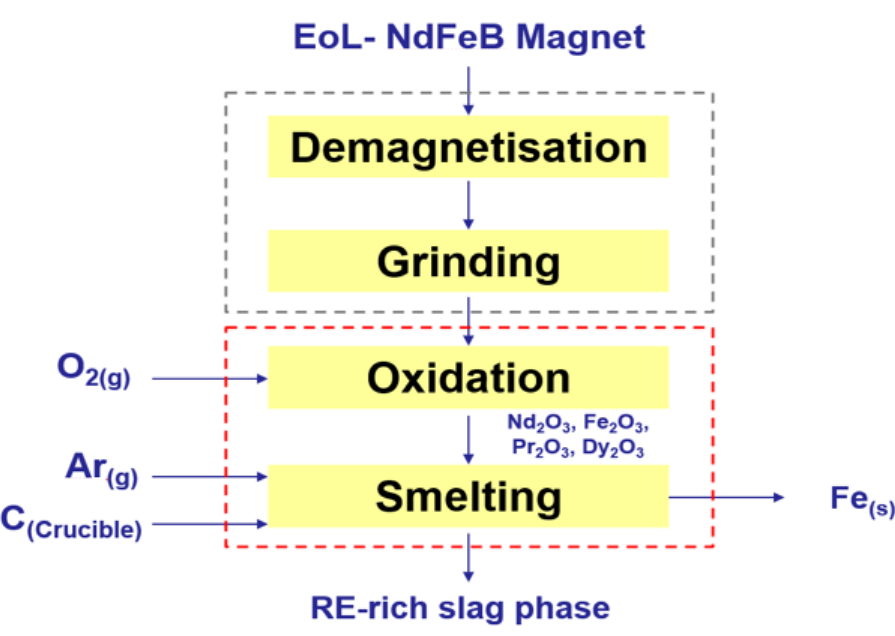
Figure 1. Proposed strategy for study in this work.